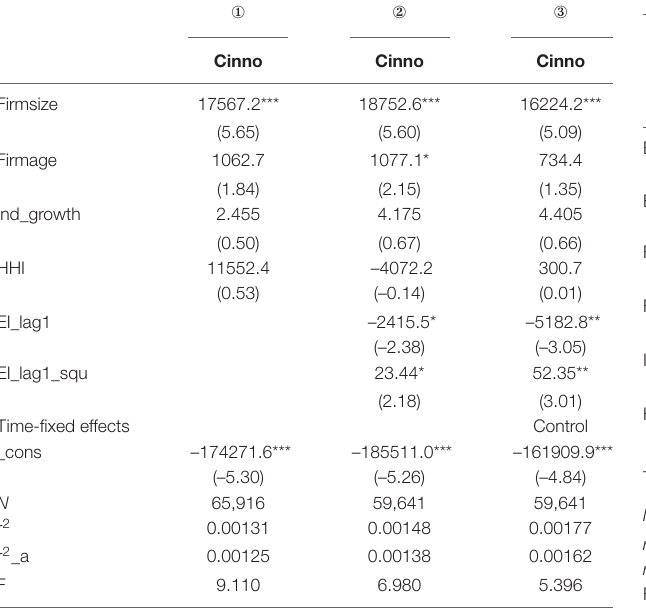
TABLE 6 | Results of the U-shaped relationship test including non-exporting firms. TABLE 7 | Results of the sub-sample analysis of the reversal mechanism of the U-shaped